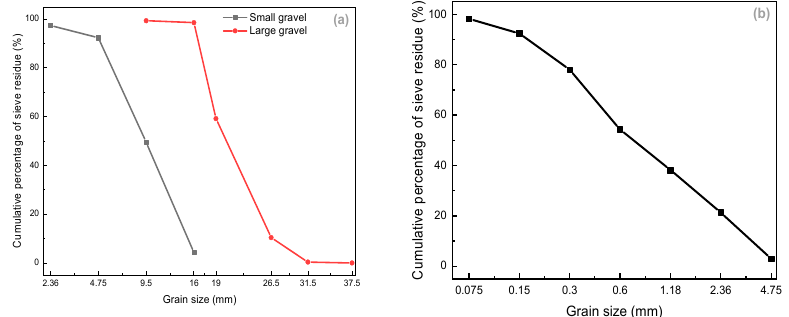
Figure 1. Coarse aggregate ( a ) and fine aggregate ( b ) sieving curve.